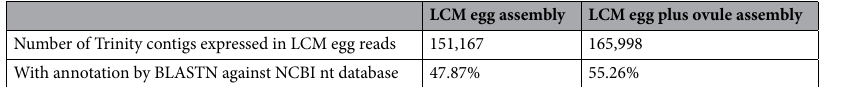
Table 3. Assembly and annotation statistics for de novo egg assembly and egg cell-expressing transcripts in LCM egg plus ovule combined assembly.